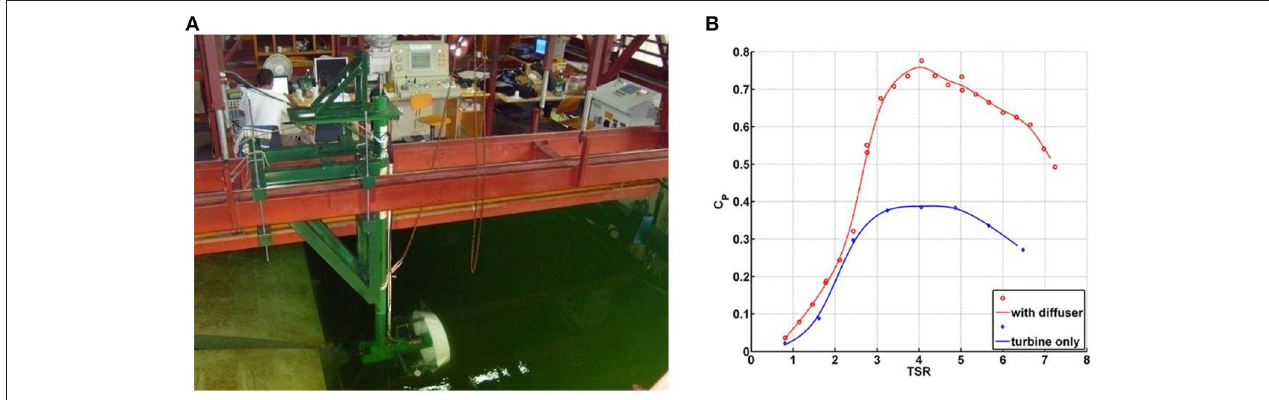
FIGURE 3 | Single turbine test system mounted on towing tank carriage (A) . Power coefficient for single isolated turbine. Comparison between bare and ducted turbine ( φ = 26 ◦ ). Relative speed 2.0 m/s (B)